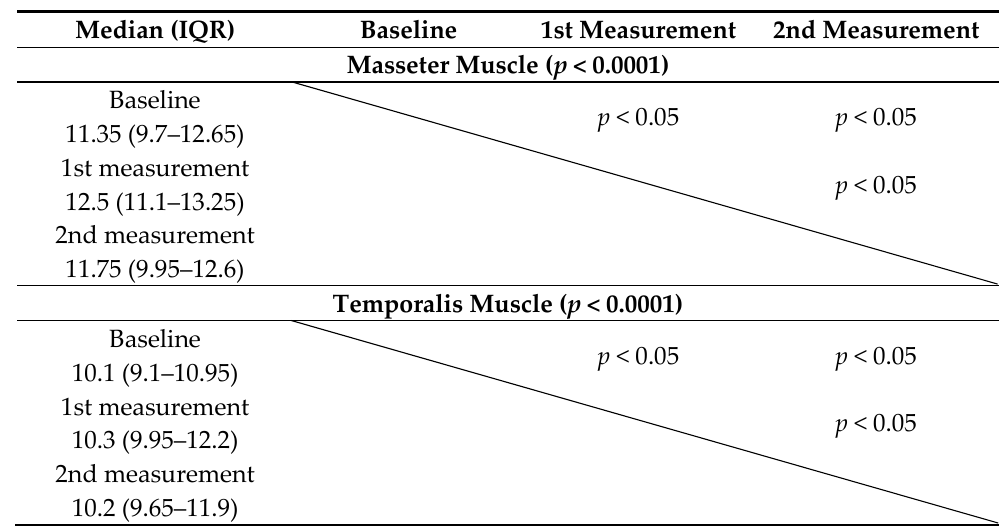
Table 3. Comparison of the shear wave elastography results using the Friedman test with pair-wise comparisons.